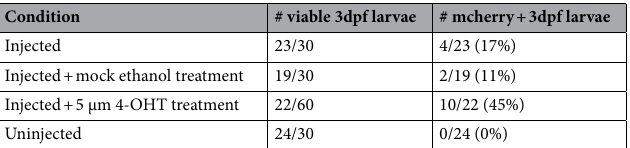
Table 2. Tamoxifen responsive Cre recombinase activity in neurod1-2A-CreERT2 targeted